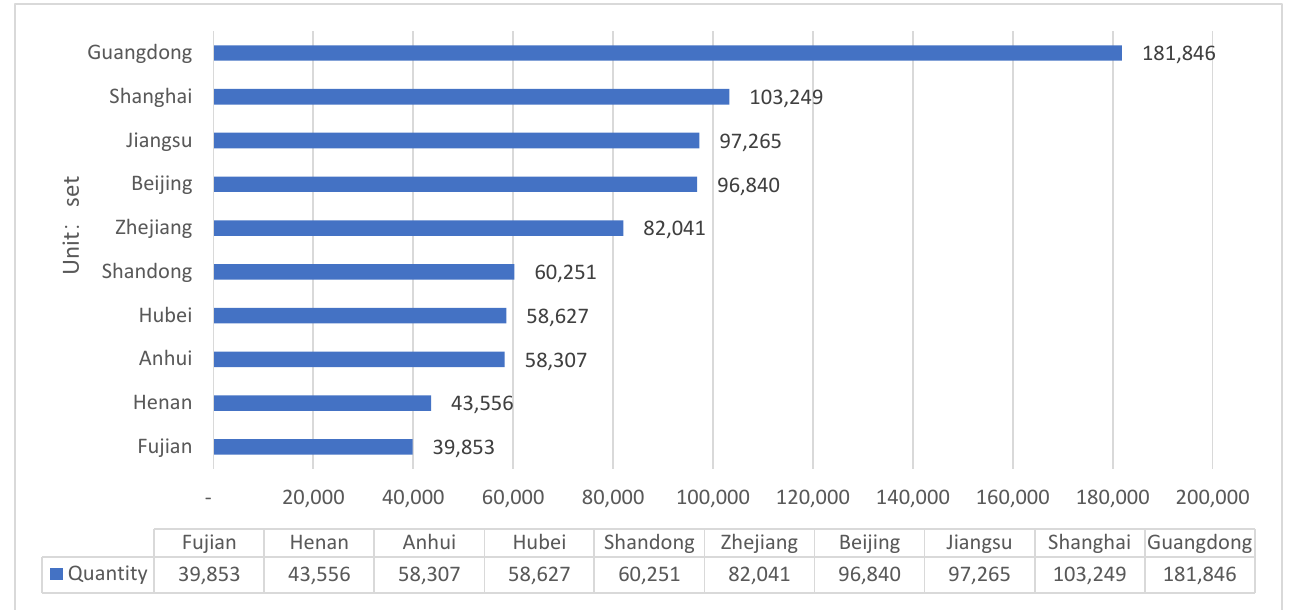
Figure 3. Ranking the public charging piles in China in 2020. Data Source: China Electric Vehicle